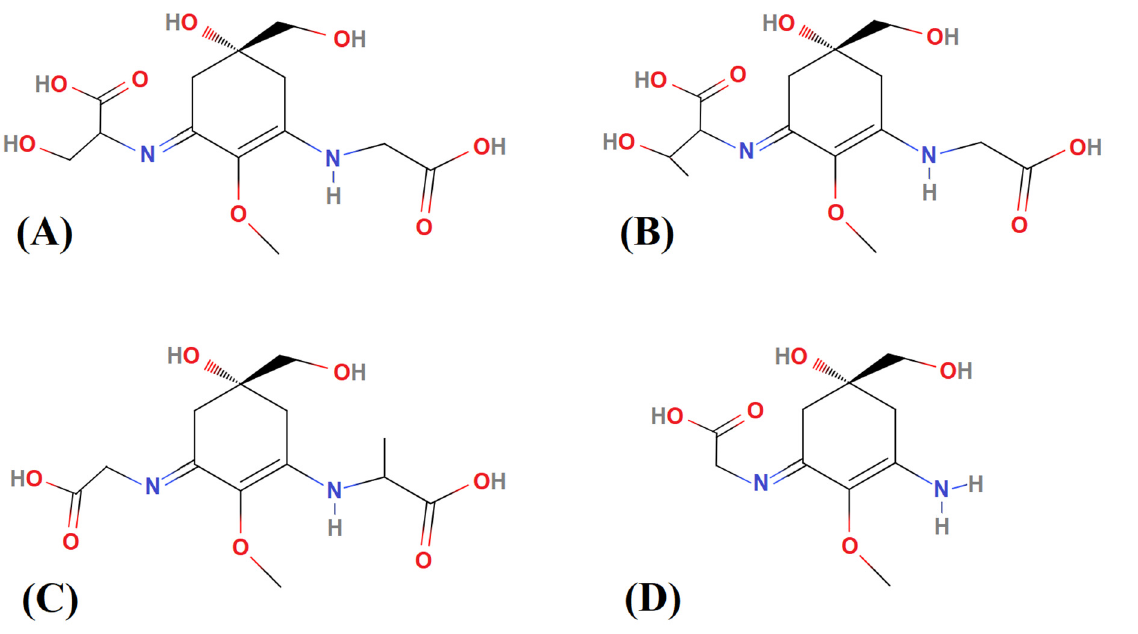
Figure 3. Chemical structure of each MAA standard used for quantitative analyses. ( A ) Shinorine, ( B ) porphyra-334, ( C ) mycosporine-glycine-alanine, and ( D ) palythine.